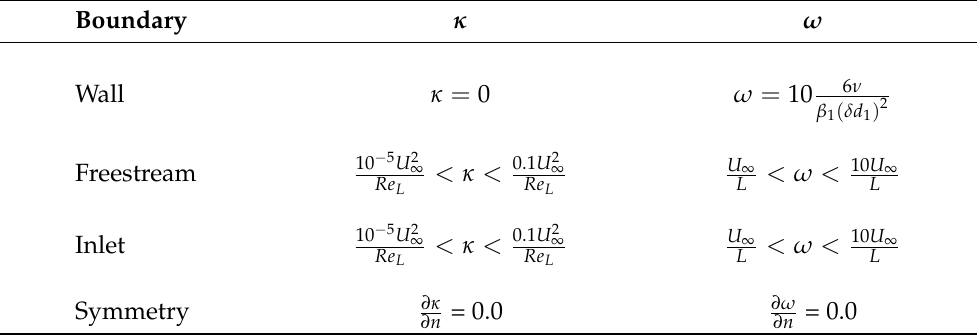
Table 1. Shear Stress Transport boundary conditions ( L -length of computational domain, U ∞ -velocity at upstream infinity).